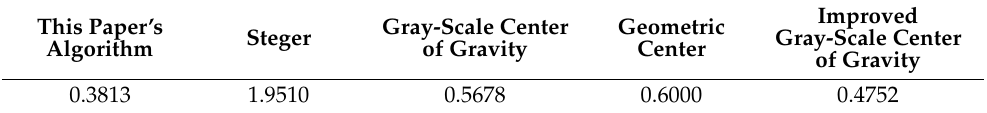
Table 1. The RMSD difference of each algorithm.